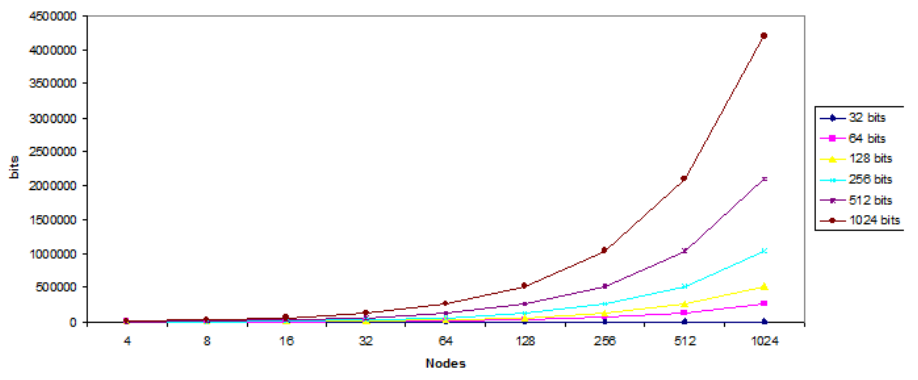
Figure 7. Size of the message created by U c